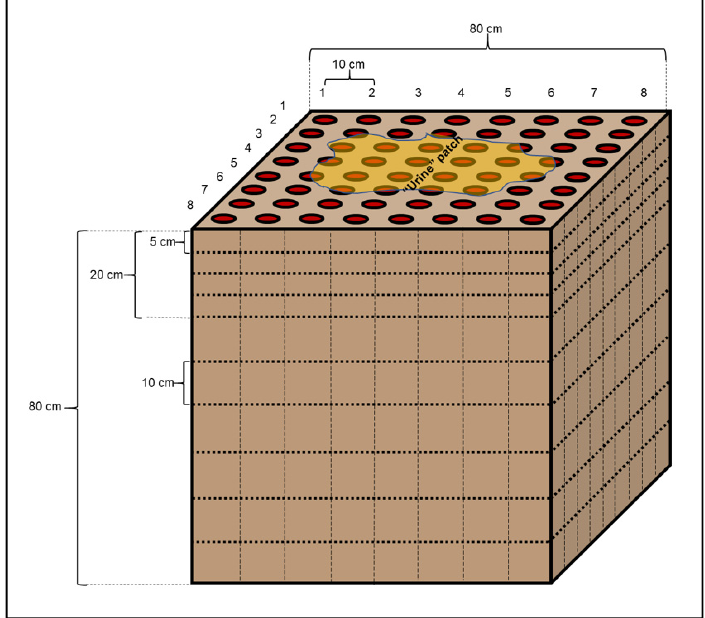
Figure 2. Schematic design of the experiment into the soil. Each circle indicates the position of each soil sampled down to 80 cm of depth, divided into each layer. The yellow irregular spot indicates the patch after applied the KBr solution.